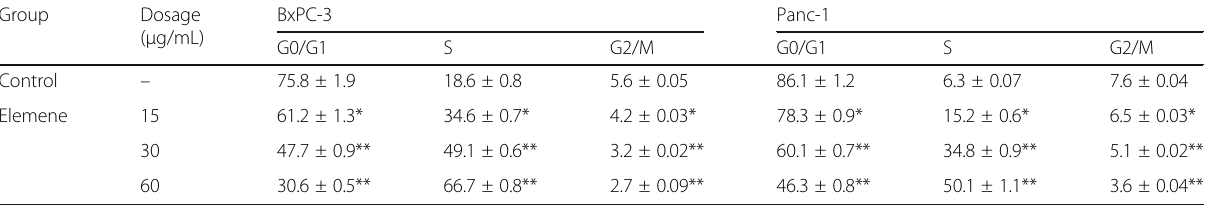
Table 2 The cell cycle distribution on BxPC-3 and Panc-1 cell line after 12 h of elemene treatment Group